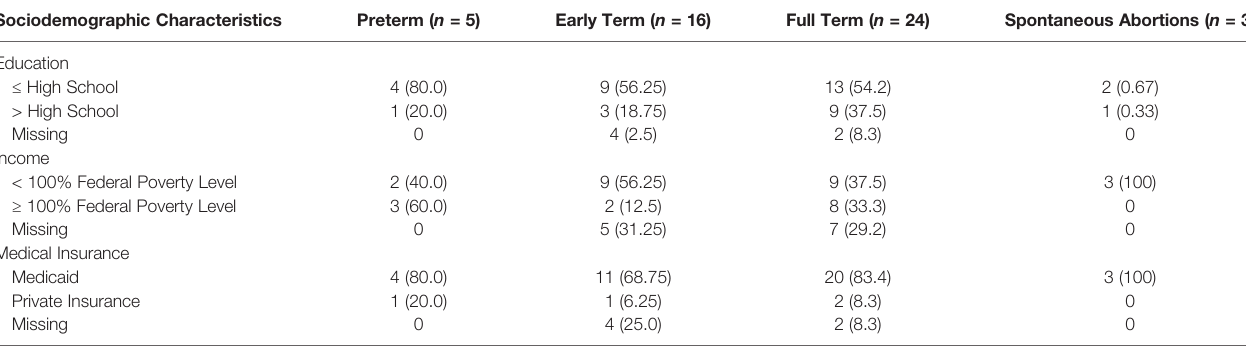
TABLE 1 | Sociodemographic characteristics of participants according to birth outcomes ( N = 50). Sociodemographic